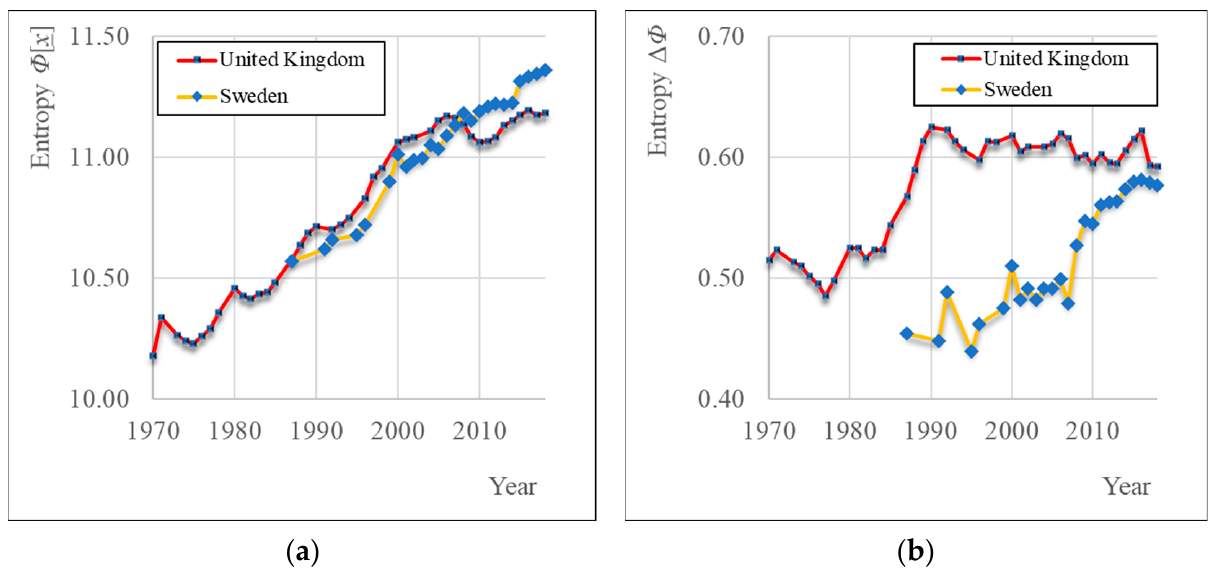
Figure 18. Sweden and United Kingdom, timeline of: ( a ) entropy Φ [ x ]; ( b ) entropic index of inequality Δ Φ .